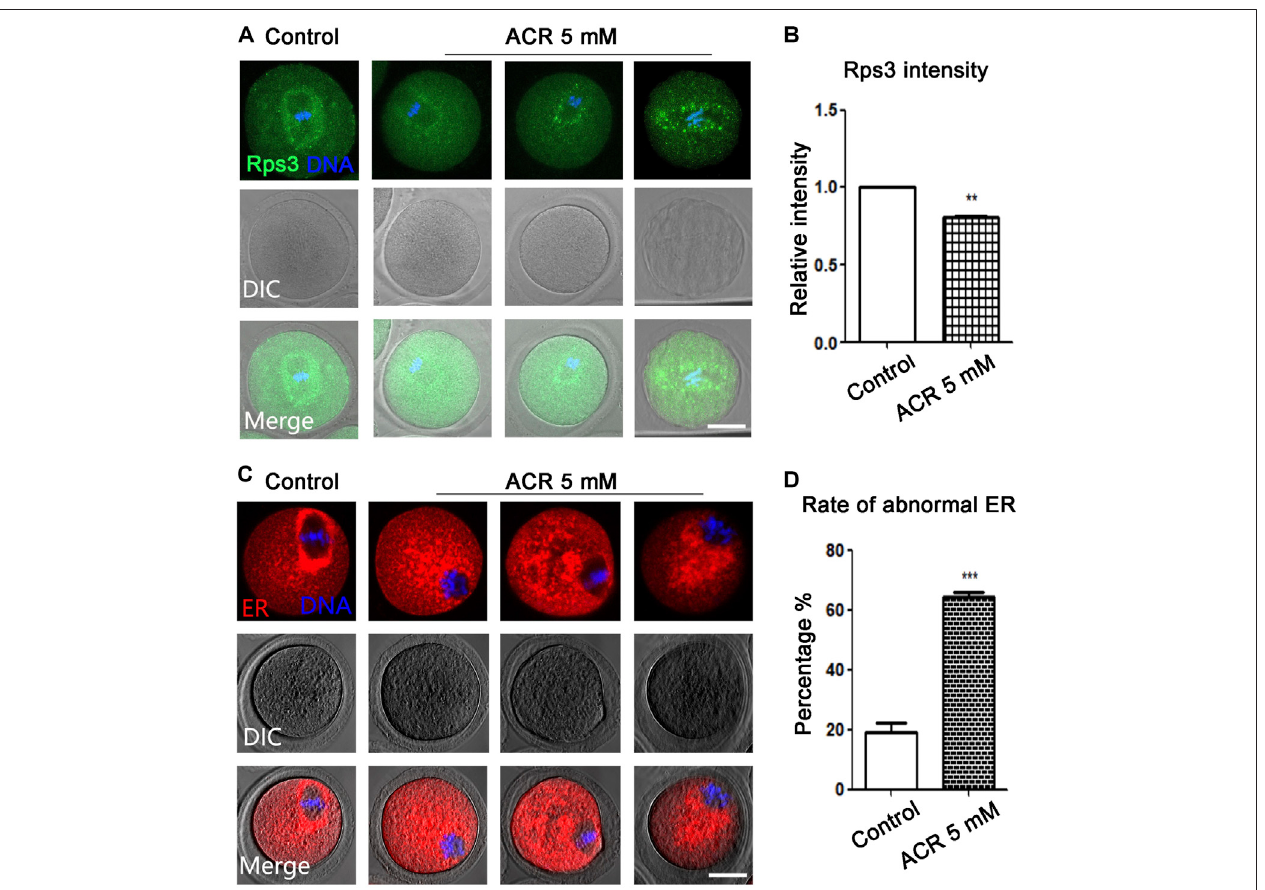
FIGURE 3 | ACR decreases the distribution of ribosome protein Rps3 and ER in oocytes. (A) The typical fl uorescence picture of ribosome protein Rps3 after ACR treatment. Rps3 diffused from the spindle periphery after ACR exposure compared with the control group. Green, Rps3; blue, DNA. Bar = 30 μ m. (B) The fl uorescence intensity of Rps3 after ACR exposure was signi fi cantly higher than that of the control group. * p < 0.05. (C) The typical picture for the distribution of ER after ACR treatment.Similartoribosome,theERdiffusedfromthespindleperipheryafterACRexposurecomparedwiththecontrolgroup.Red,ER-Tracker.Bar=30 μ m. (D) The abnormal rate of ER increased signi fi cantly in the 5 mM ACR group compared with the control group. *** p < 0.001.